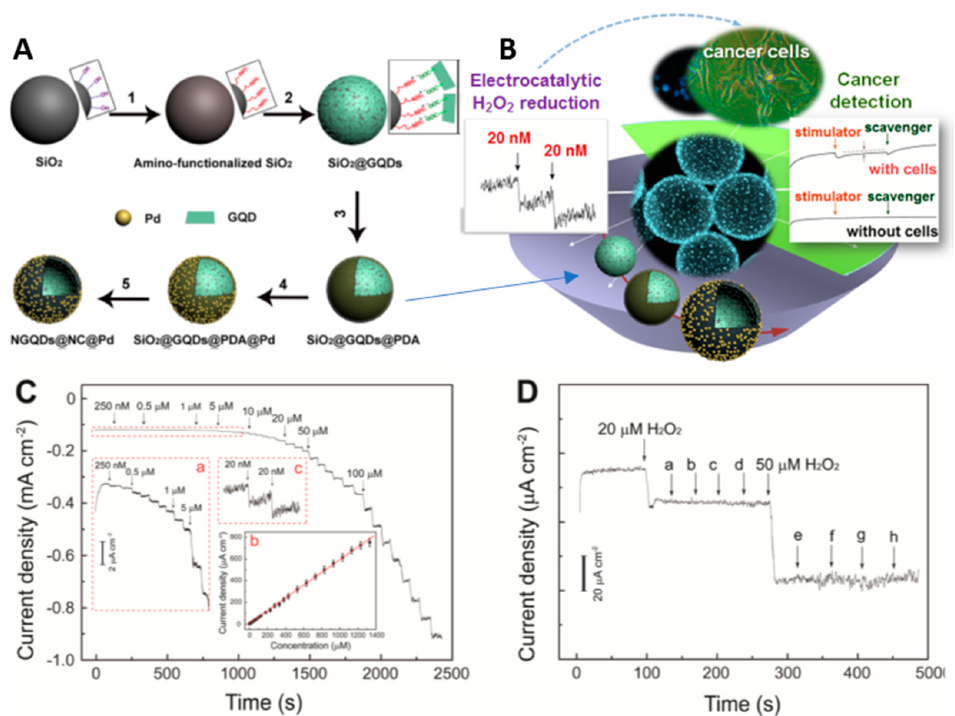
Figure 4. Preparation and application of N-doped graphene quantum dots@N-doped carbon@Pd hollow nanospheres in the H 2 O 2 detection; ( A ) preparation process of NGQDs@NC@Pd HNSs; ( B ) schematic representation of the application field of GQD@NC@Pd/GCE sensor; ( C ) amperometric response of NGQDs@NC@Pd/GCE with successive step changes of H 2 O 2 concentration; ( D ) influence of interfering compounds. Adapted with the permission of Ref.